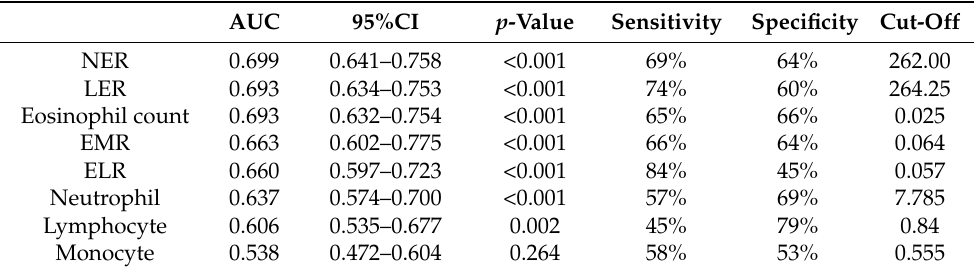
Table 2. ROC curve analysis demonstrating the cut-off values for eosinophil indices to predict the 6-moths